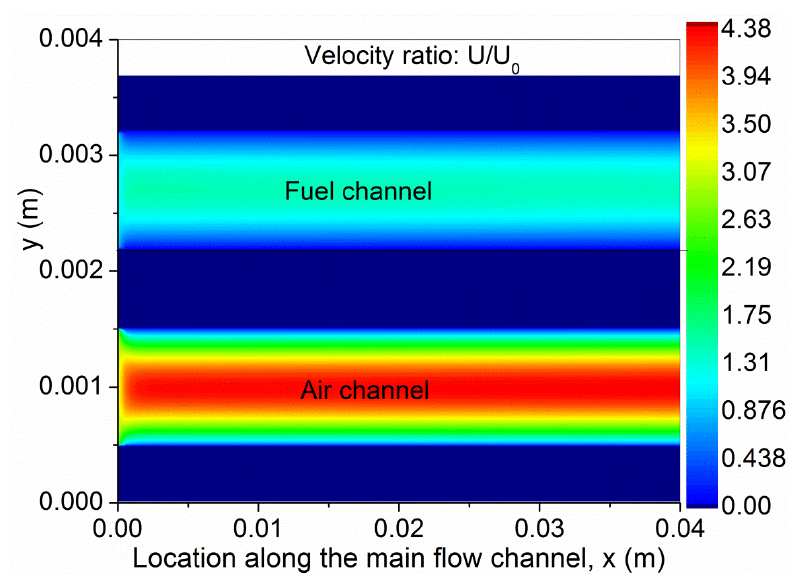
Figure 5. Velocity contours in